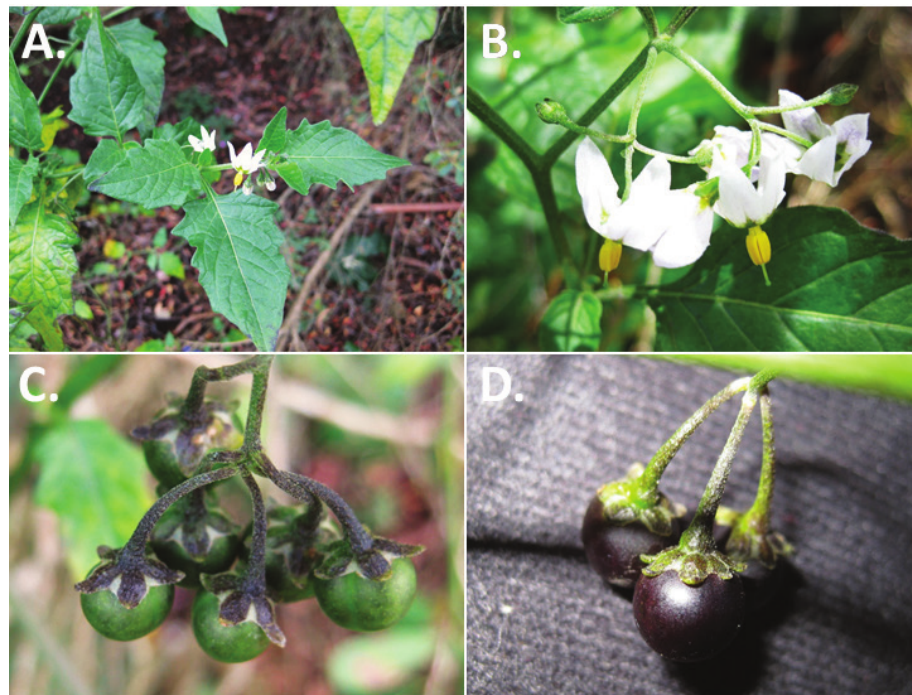
Figure 19. Solanum furcatum Dunal A Flowering branch B inflorescence with flowers at full anthesis C developing fruits D mature fruits ( A–D Knapp s.n. Golden Gate Park). Photos by S.